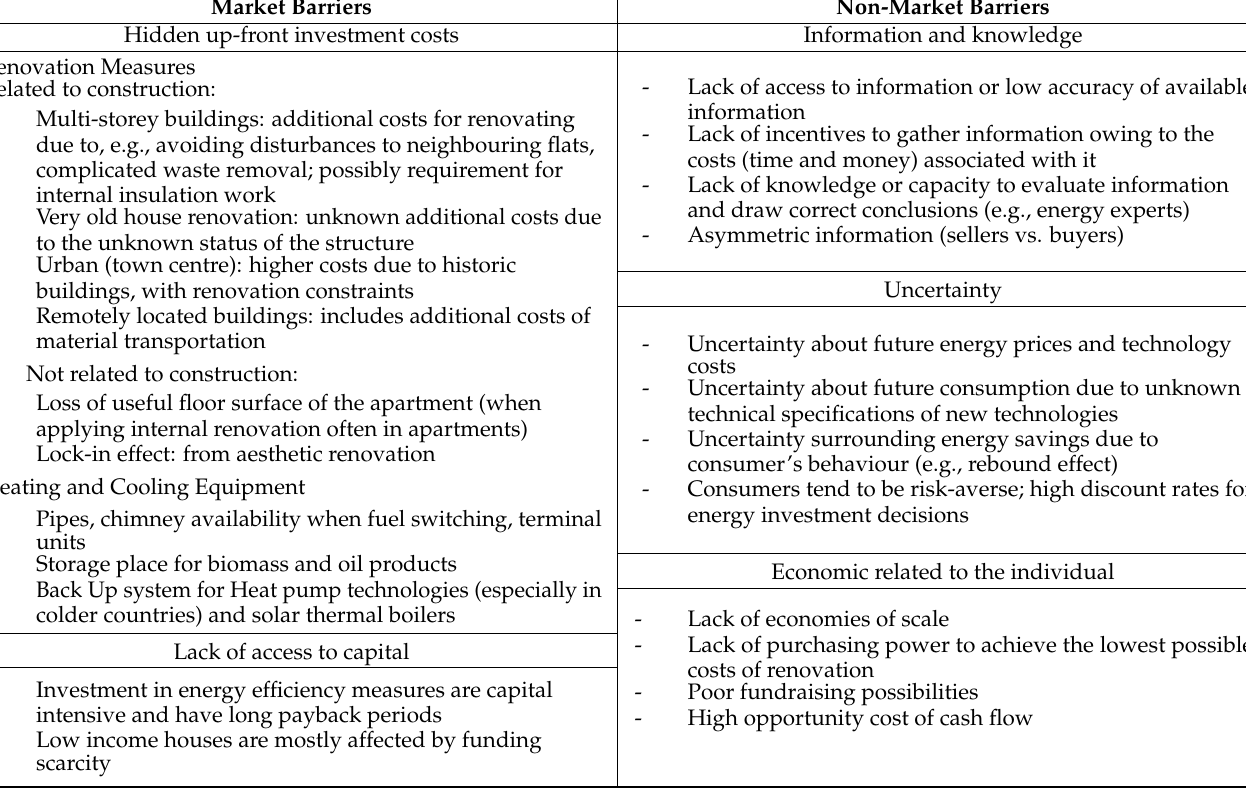
Table 1. Taxonomy of market and non-market barriers to energy efficiency for buildings in the residential